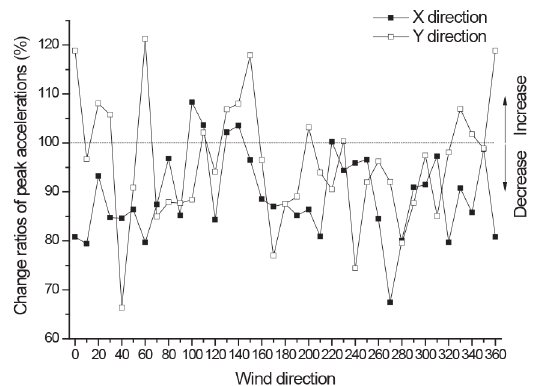
Fig. 10. Reduction ratios of the maximum acceleration after applying the resizing method